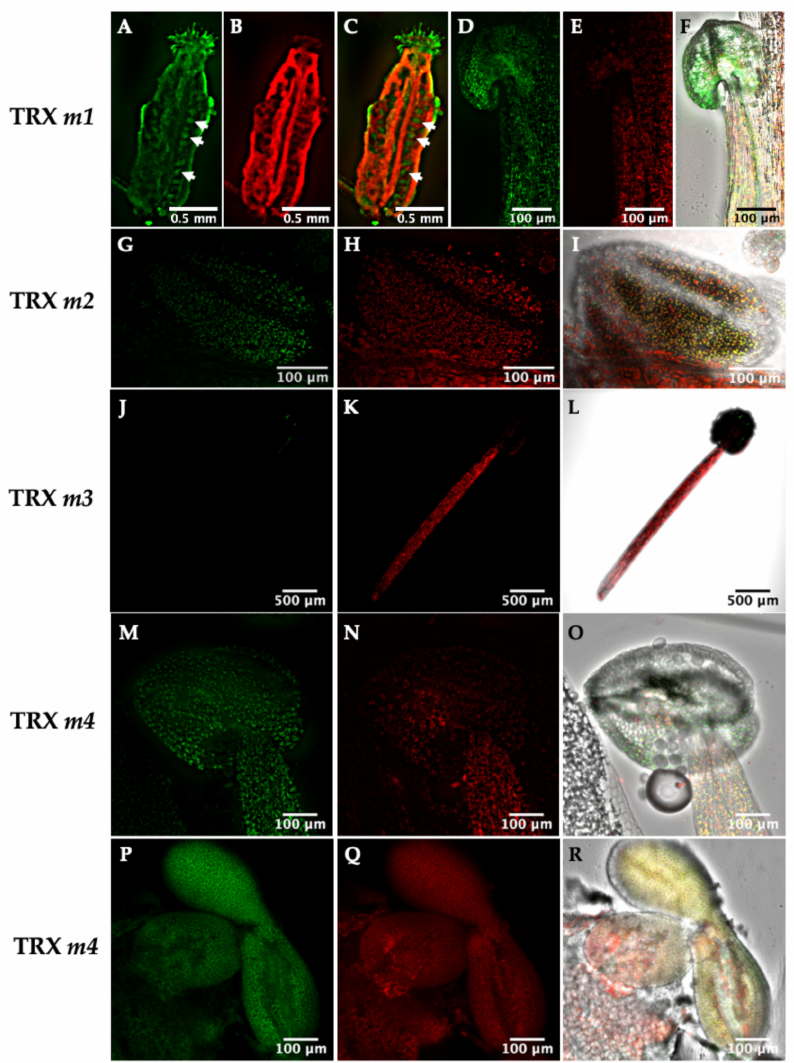
Figure 3. Representative confocal images of Arabidopsis lines expressing the TRX m ::GFP constructs in reproductive tissues of 4-week-old Arabidopsis plants. TRX m expression was followed in different reproductive tissues: ( A – C ) ovary, ( D – O ) stamens and ( P – R ) torpedo stage embryo. Images show the emitted fluorescence signals or an overlay of the fluorescence and bright-field signals: fusion–protein fluorescence ( A , D , G , J , M , P ); chlorophyll autofluorescence ( B , E , H , K , N , Q ); computer overlay of the two fluorescence images ( C ); computer overlay of fluorescence and bright-field images ( F , I , L , O , R ). Arrows highlight ovules in an Arabidopsis